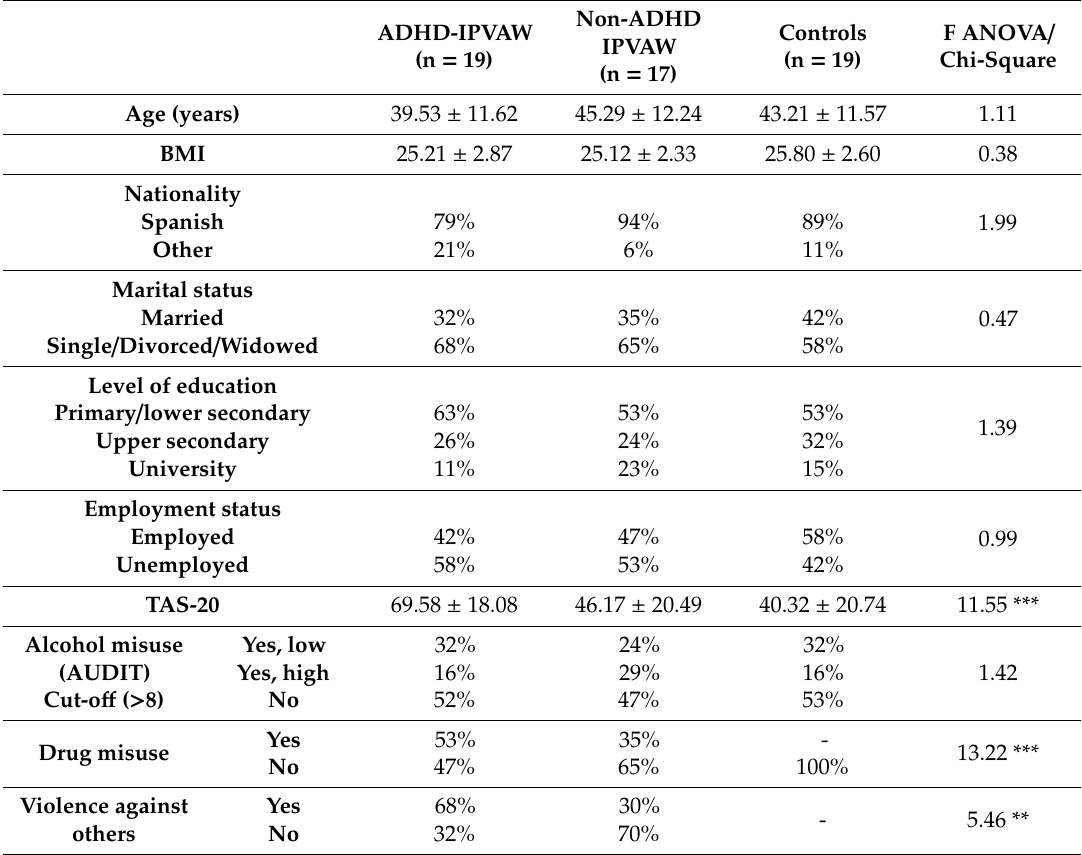
Table 1. Mean ± SD of demographic characteristics and psychological variables for all